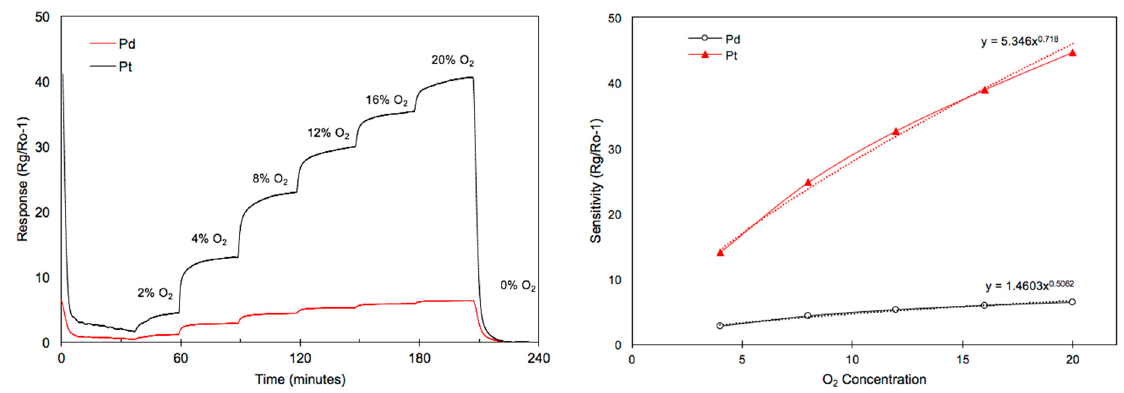
Figure 4. Dynamic response ( left ) and sensitivity ( right ) of indium oxide based sensors to different O2 concentrations at 200